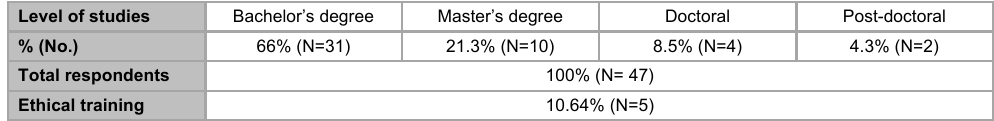
Distribution of respondents according to their level of education